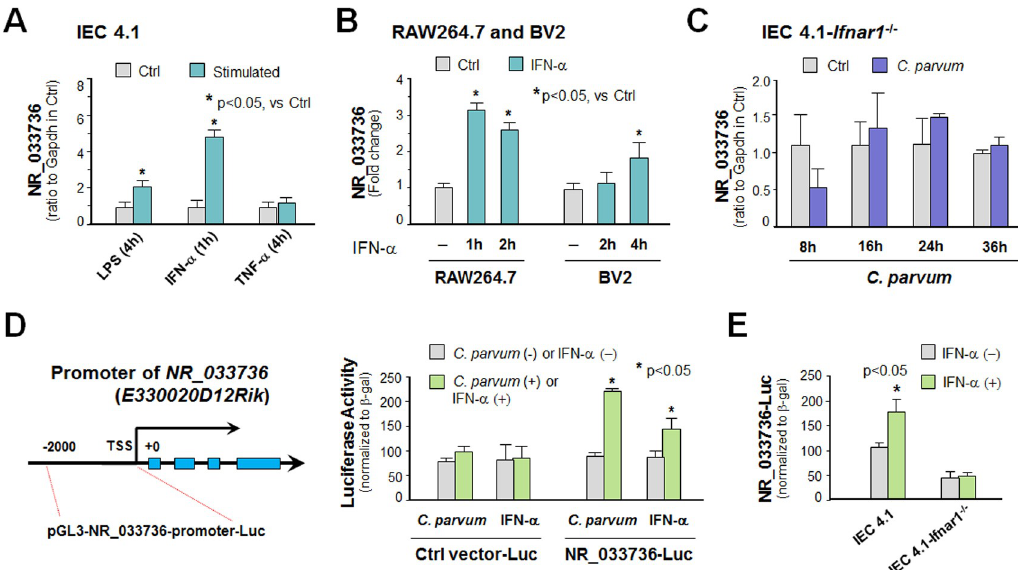
Fig 2. Upregulation of NR_033736 is triggered by type I IFN signaling in intestinal epithelial cells and macrophages. (A) Upregulation of NR_033736 in IEC4.1 cells following stimulation with LPS, IFN- α and TNF- α . Cells were treated with LPS, IFN- α and TNF- α for 2 h and expression level of NR_033736 was validated by using qRT-PCR. (B) Upregulation of NR_033736 in cultured murine macrophages (RAW287.4 cells) and microglia (BV2 cells) following IFN- α stimulation. Cells were treated with IFN- α for 2 h and expression level of NR_033736 was quantified by using qRT-PCR. (C) Upregulation of NR_033736 induced by C . parvum infection was not observed in IEC4.1 cells with deficient in Ifnar1 . Stable IEC4.1 cells were exposed to C . parvum infection for 8–36 h and expression level of NR_033736 was quantified. (D) C . parvum infection and IFN- α stimulation trigger the luciferase activity associated with the NR_033736 promoter in IEC4.1 cells. The 2-kb upstream of the transcription start site of NR_033736 was cloned and inserted into the pGL3-Basic luciferase reporter construct. Cells were transfected with the generated reporter constructs and then exposed to C . parvum infection (for 8 h) or IFN- α stimulation (for 4 h). Infection and IFN- α stimulation triggered the luciferase activity associated with the NR_033736 promoter in IEC4.1 cells. (E) Luciferase activity associated with the NR_033736 promoter in IEC4.1 cells with deficient in Ifnar1 in response to IFN- α stimulation. Cells were transfected with the generated reporter constructs and then treated with IFN- α for 4 h, followed by measurement of luciferase activity associated with the NR_033736 promoter. Data represent three independent